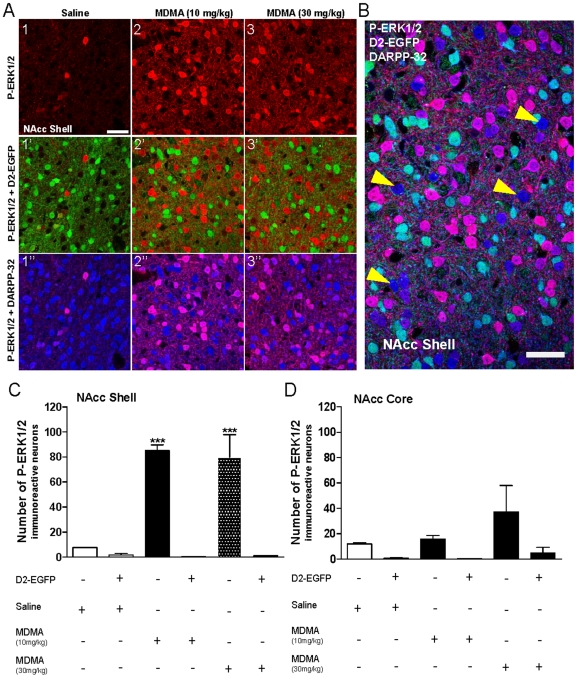
MDMA reexposure after CPP induces strong ERK1/2 activation exclusively in striatonigral medium-sized spiny neurons (MSNs) of the NAcc shell.
drd2-EGFP BAC transgenic mice, in which EGFP expression is driven by the D2-receptor promoter, were trained for the same CPP protocol as in Figure 3 and re-exposed 24 hours after CPP training to saline, MDMA 10 mg/kg or MDMA 30 mg/kg. A) Single confocal sections showing p-ERK1/2 immunoreactivity (1–3, red) colocalized with D2-mediated EGFP (1′–3′, green) and DARPP-32 immunoreactivity (1″–3″, blue) in the NAcc Shell of drd2-EGFP mice 10 minutes after re-exposure to saline (1–1″), MDMA 10 mg/kg (2–2″) or MDMA 30 mg/kg (3–3″). The absolute segregation from D2-EGFP neurons in 1′–3′ and the complete colocalization with a fraction of DARPP-32-positive neurons in 1″–3″ reveal the identity of neurons expressing ERK1/2 activation, which are D1 receptor-containing striatonigral MSNs. Scale bar: 40 µm. B) p-ERK1/2 (red) + D2-EGFP (green) + DARPP-32 (blue) colocalized confocal image of the NAcc shell of an animal challenged with 10 mg/kg MDMA. Arrows point to neurons labeled only in blue, which are the small fraction of striatonigral MSNs that do not show ERK activation. Scale bar: 40 µm. C) Quantification of p-ERK1/2 immunoreactive neurons among EGFP-negative (−) or EGFP-positive (+) neurons in the NAcc Shell of drd2-EGFP mice 10 min after saline, MDMA 10 mg/kg or MDMA 30 mg/kg injections. D) Quantification of p-ERK1/2 immunoreactive neurons among EGFP-negative (−) or EGFP-positive (+) neurons in the NAcc Core of drd2-EGFP mice 10 min after saline, MDMA 10 mg/kg or MDMA 30 mg/kg injections. Data (means±SEM; n = 3 mice per group) were analyzed using two-way ANOVA with genotype and treatment as main factors, revealing a significant interaction F(2, 12) = 16.8, p<0,001 and a main effect of treatment F(2, 12) = 15.93, p<0,001 as well as of genotype F(1, 12) = 83.71, p<0.001. Bonferroni tests were used for post-hoc comparisons. The null hypothesis was rejected at the p<0.05 level; *** p<0.001 compared to saline-treated mice.